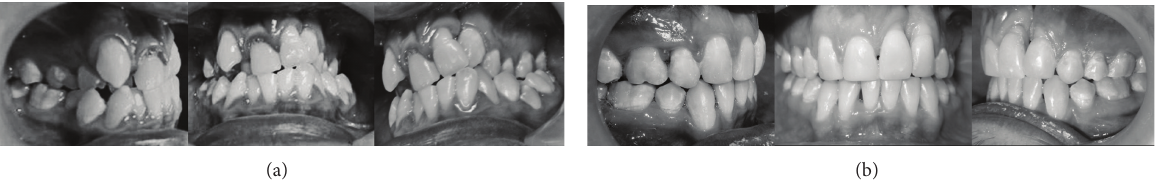
Figure 4: Intraoral images at the beginning (a) and at the end (b) of the treatment. Canines were remodeled as lateral incisors with composite.